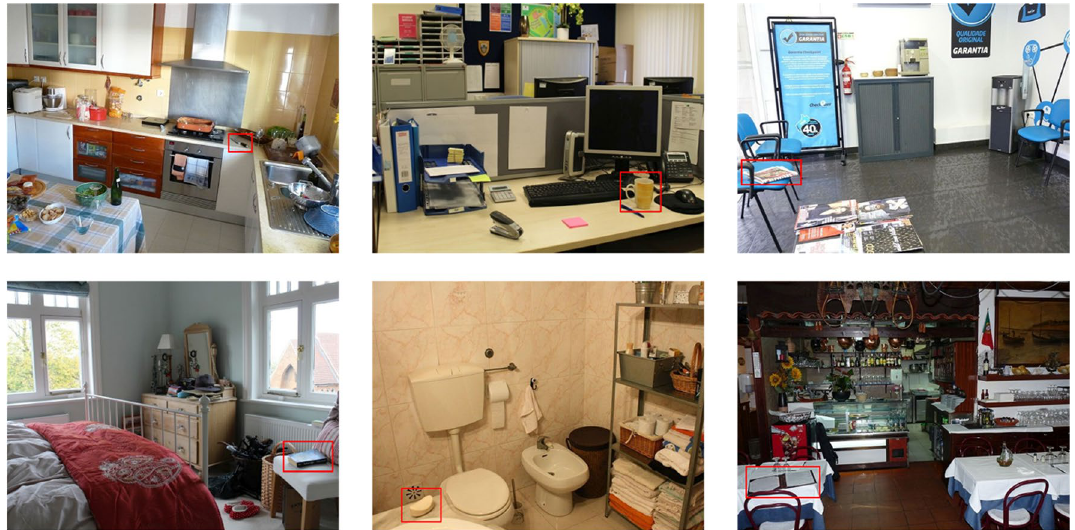
Figure 1. Examples of the type of scenes used in the study. For illustration, critical objects are shown surrounded by a red square, which was not present during the experiment.